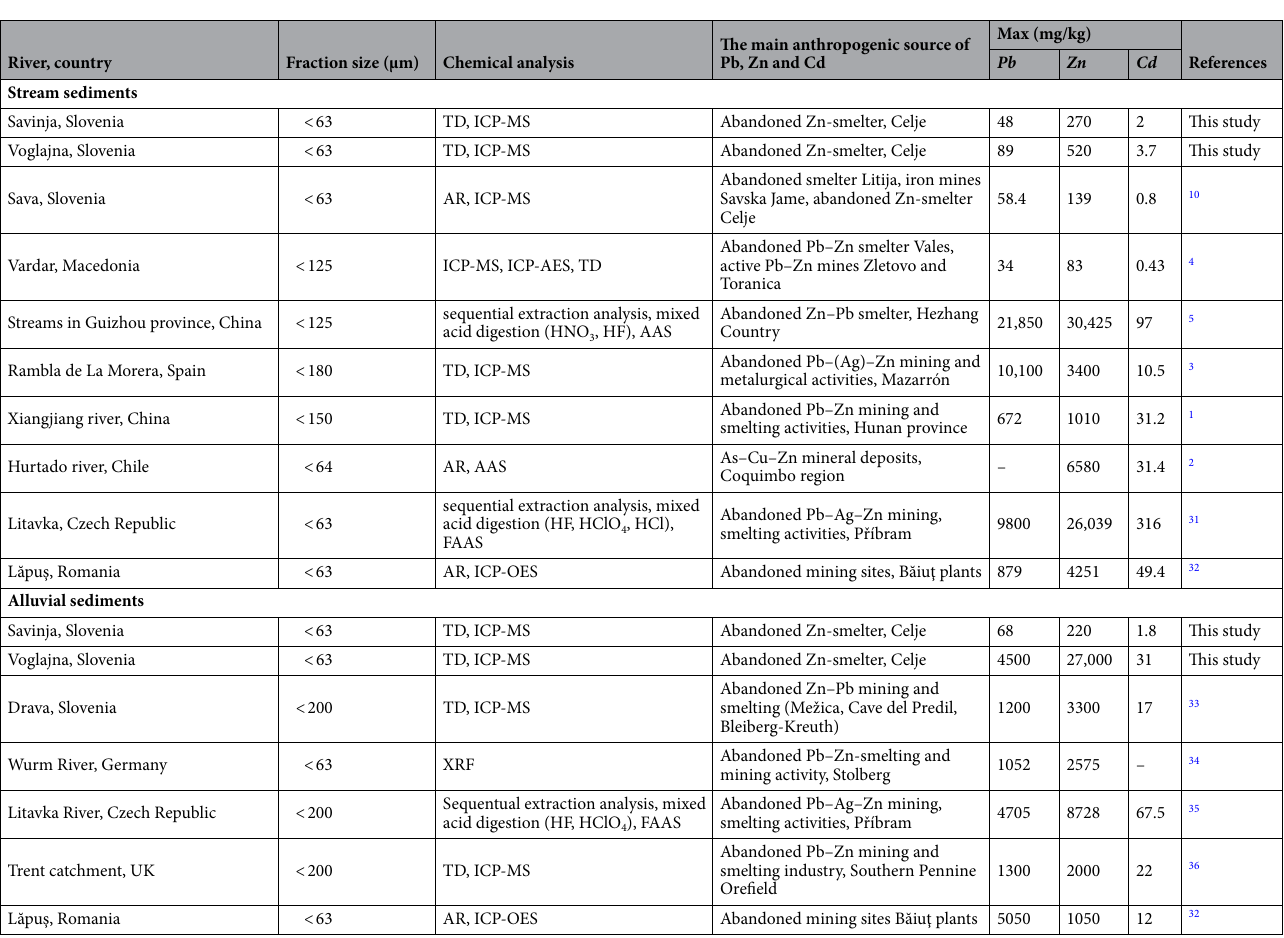
Table 5. Maximum elemental levels in stream and alluvial sediment samples from the present and similar studies globally. AAS atomic absorption spectrometry, FAAS flame absorption atomic spectrometry, ICP-MS inductively coupled plasma mass spectrometry, ICP-AES inductively coupled plasma atomic emission spectrometry, ICP-OES inductively coupled plasma optical emission spectrometry, AR aqua regia digestion, TD total acid